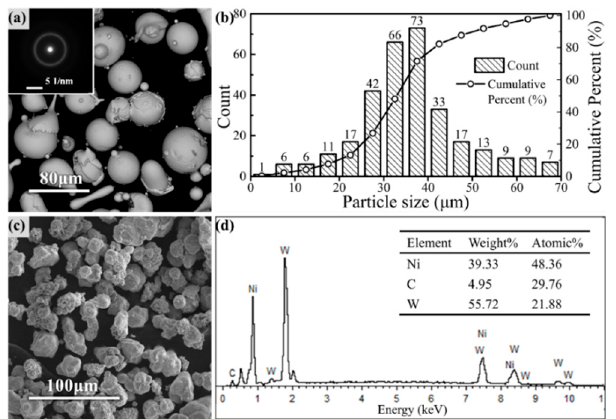
Figure 1. SEM micromorphology of the feedstock powders: ( a ) surface morphology and the SAED pattern of Fe-based amorphous powders; ( b ) granulometric distribution of Fe-based amorphous powders; ( c ) surface morphology of the reinforcing phase particles; ( d ) chemical component of the WC wrapped by Ni.